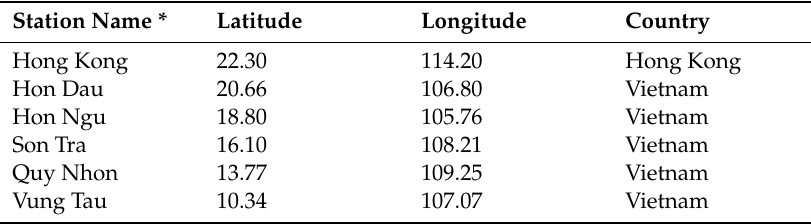
Table 2. Tide gauge information.